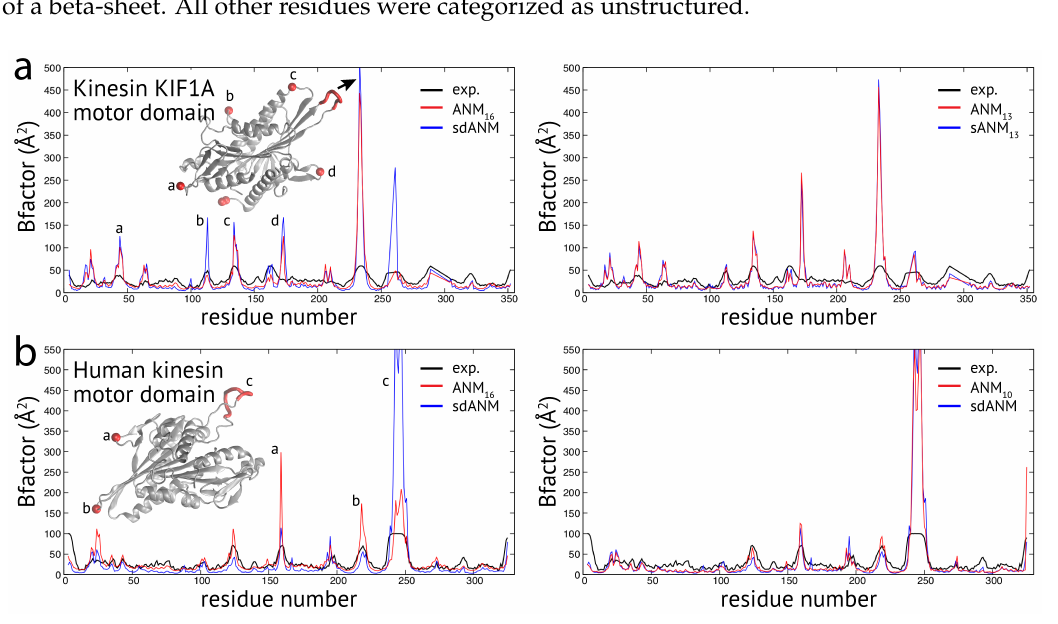
Figure A1. Fluctuation dynamics in studied proteins. B-factor profiles for two kinesin protein structures are shown; the motor domain of ( a ) kinesin KIF1A and of ( b ) human kinesin. Model predictions are displayed as red and blue lines; corresponding experimental data is shown in black. In the B-factor profiles, positions where model estimates are significantly poor were marked for each protein. The corresponding regions in the respective protein structure are also